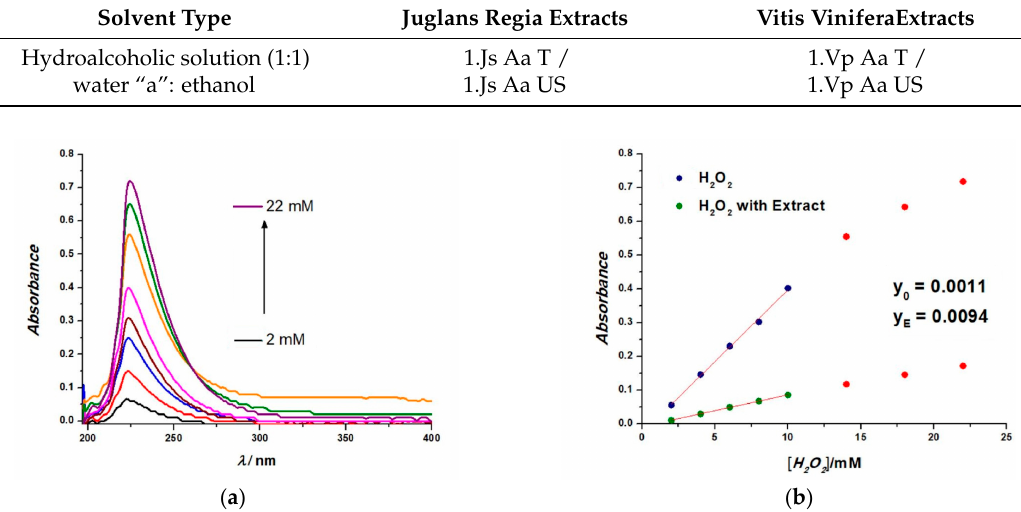
Figure 10. ( a ) Absorbance spectra at λ = 225 nm for successive H 2 O 2 addition; ( b ) Calibration plots obtained for increasing H 2 O 2 addition in the presence and absence of 1.Hf Aa US in 0.1 M NaPB, pH = 7.0, from the absorbance spectra.